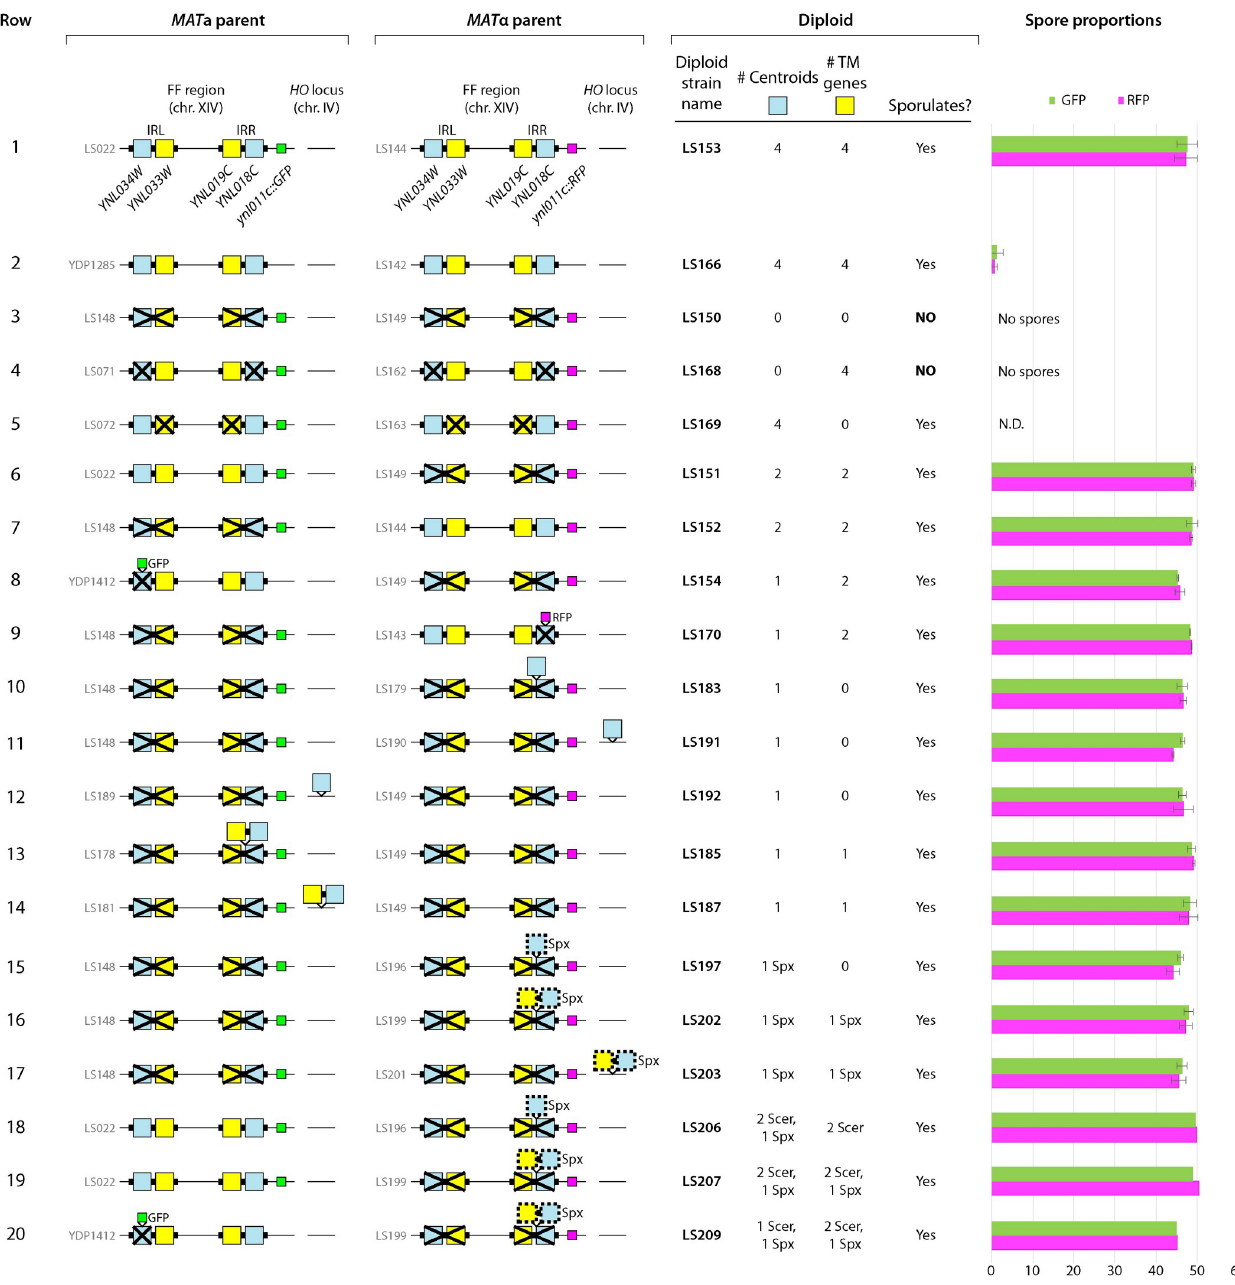
Fig 7. Centroid genes are required for sporulation, but are not meiotic drivers. Each row shows two parents ( MAT a and MAT α ) with genotypes as indicated, that were mated to form a diploid strain that was then tested for sporulation. Blue rectangles represent Centroid genes ( YNL034W , YNL018C ), and yellow rectangles represent transmembrane protein genes ( YNL033W , YNL019C ). X symbols represent deletions, and gene symbols drawn above the line represent insertions. The “Sporulates?” column indicates ability of the diploid to form tetrad asci on standard sporulation plates (examples are shown in Fig 8), and “NO” indicates that the sporulation rate was < 0.2% (no tetrads were seen in > 500 cells examined). Bar graphs on the right show the percentages of single spores expressing GFP or RFP, measured by flow cytometry after sporulation of the diploid in liquid media under conditions favoring formation of monad spores (see Materials and Methods). Error bars represent standard deviations of 2–4 replicates where conducted. “Spx” and dashed outlines of genes indicate S . paradoxus origin. “Scer” indicates S . cerevisiae , and genes with no label are also from S . cerevisiae . N.D., not determined.